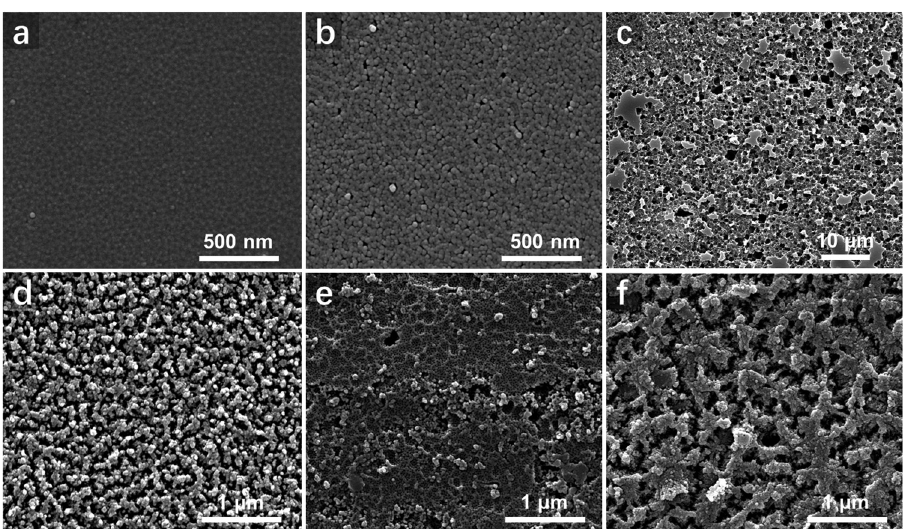
Figure 2: Surface morphologies of Al plates after anodizing. ( a ) The Al plates after cleaning, ( b – d ) Al plates anodized at 15 V for 1.5, 6, and 8 h, and ( e and f ) Al plates anodized for 6 h at 20 and 25 V,